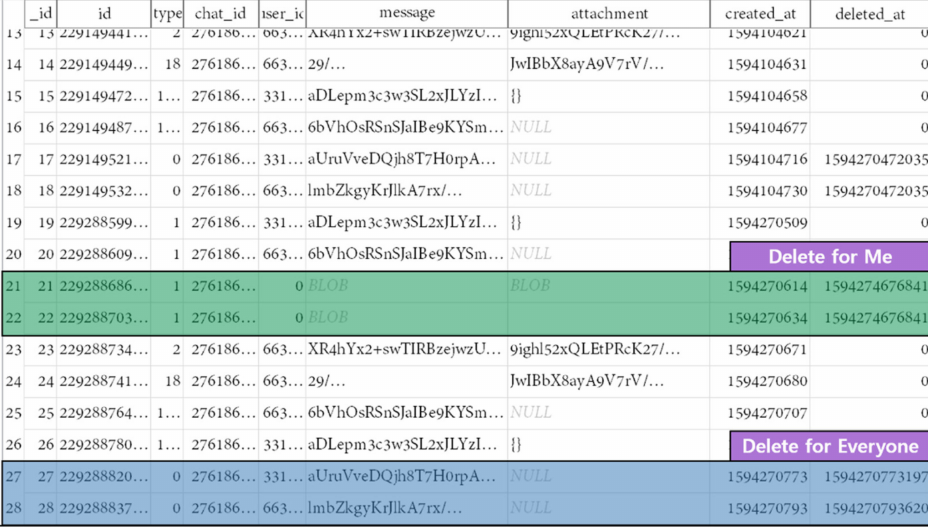
Figure 6. Inode based kakaotalk.db recovery after deleting app data using Scenario